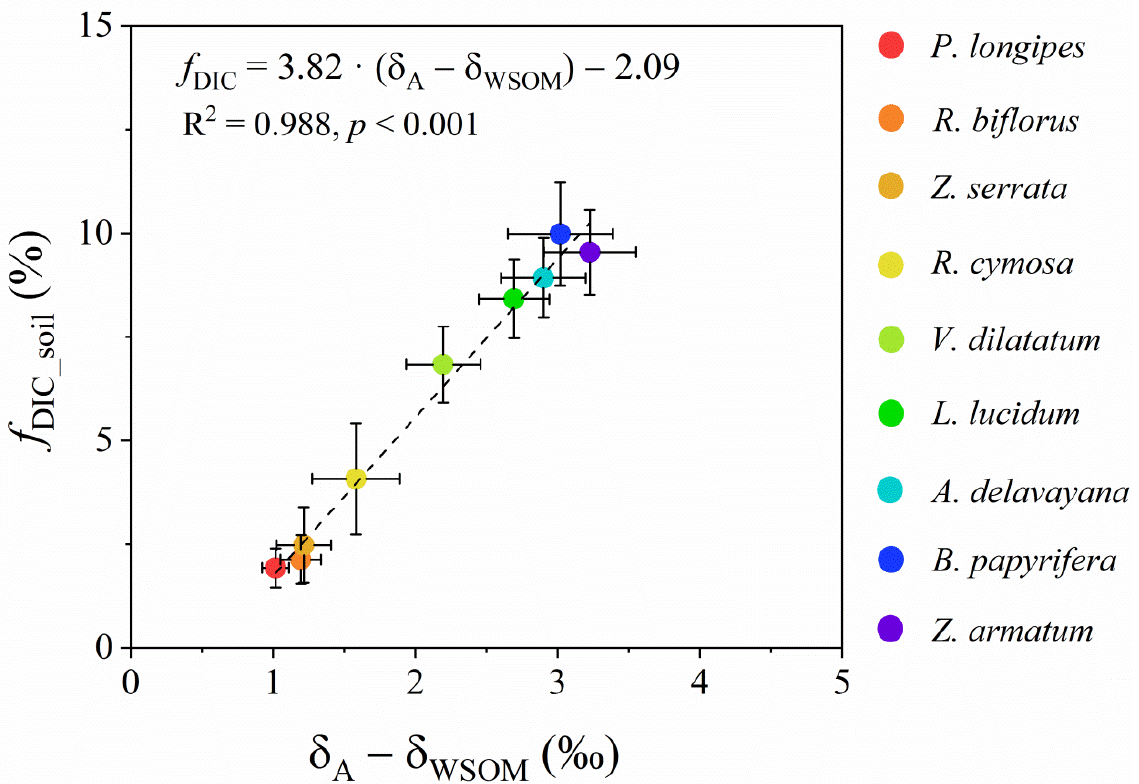
Figure 5. Relationship between ( δ A - δ WSOM ) and f DIC_soil among nine species across three altitudes. N = 4 for each species in the specific plot.